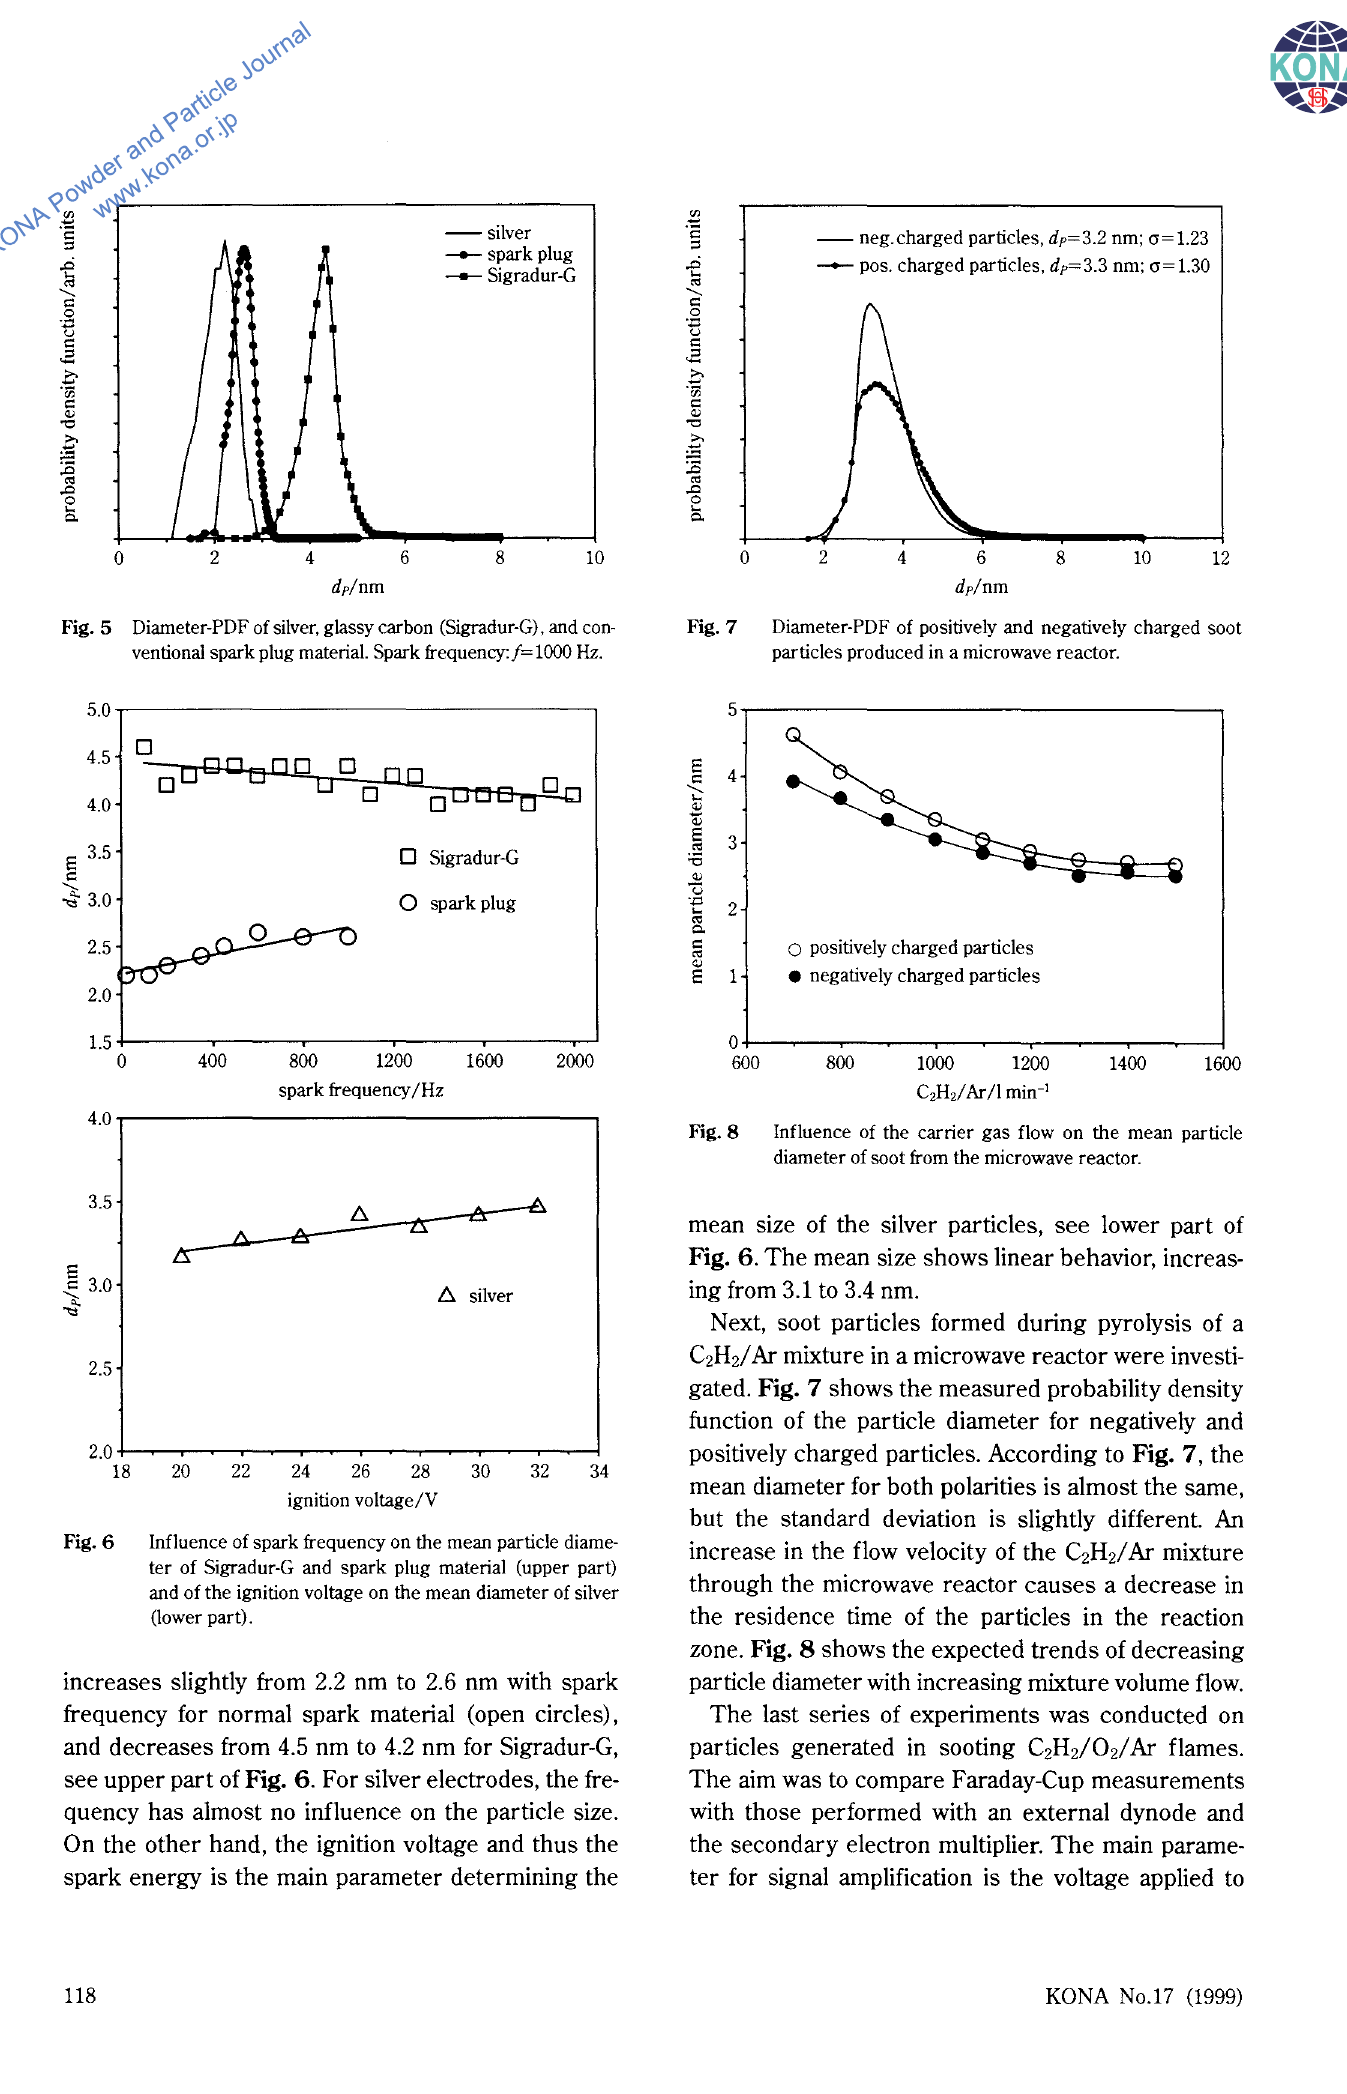
Fig. 5 Diameter-PDF of silver, glassy carbon (Sigradur-G). and con ventional spark plug material. Spark frequency:/=1000 Hz.